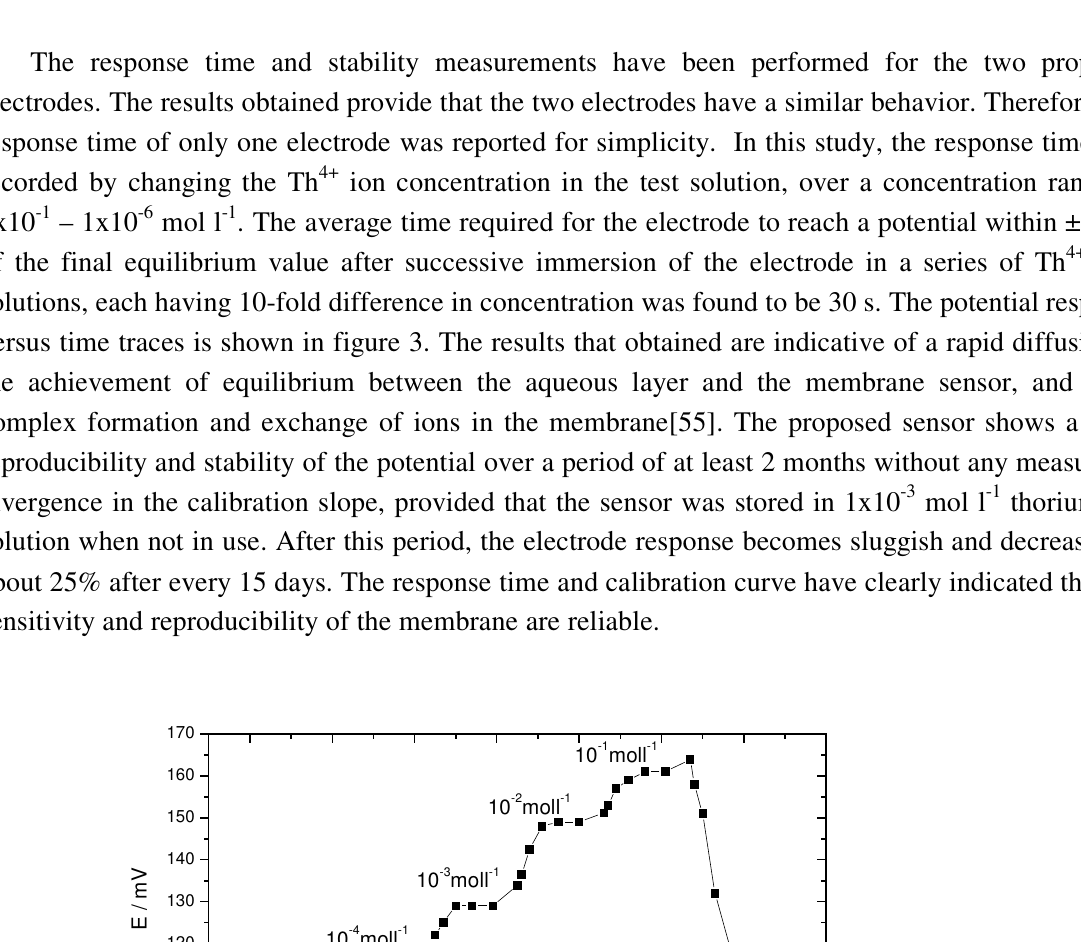
electrode.Time / min.